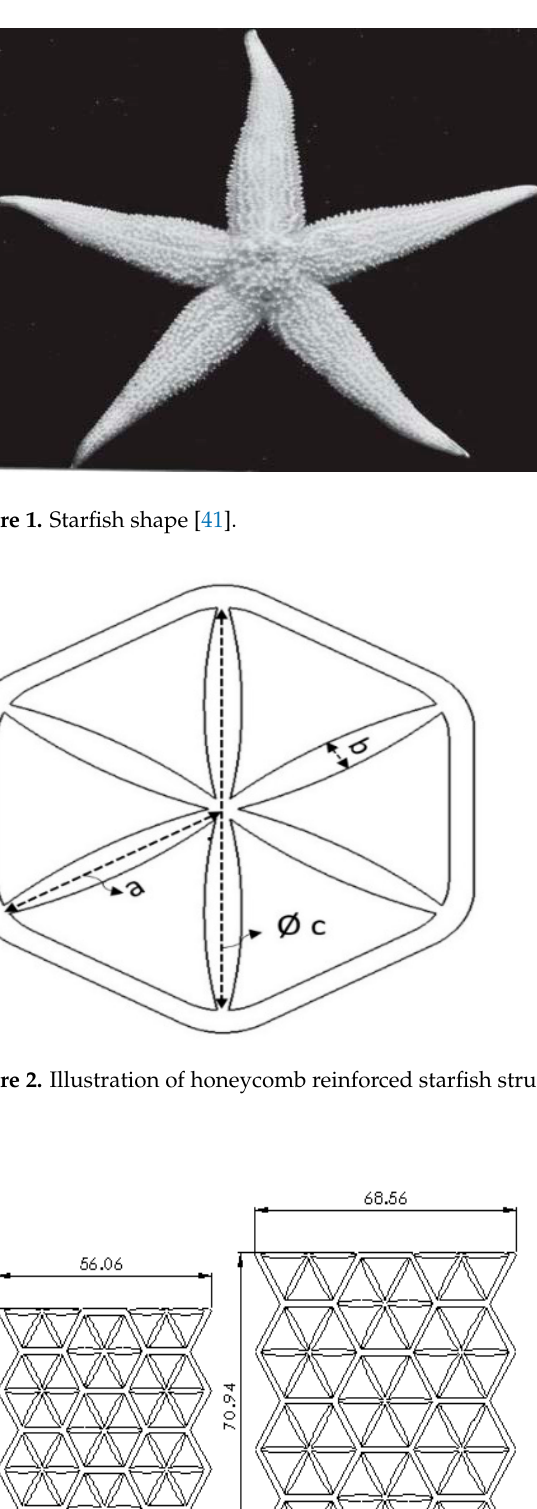
Figure 3. Cell size of ( a ) 20, ( b ) 25 and ( c ) 30 mm. Table 1. Physical properties of the 3D printed samples. Cell Size (mm) Sample No.